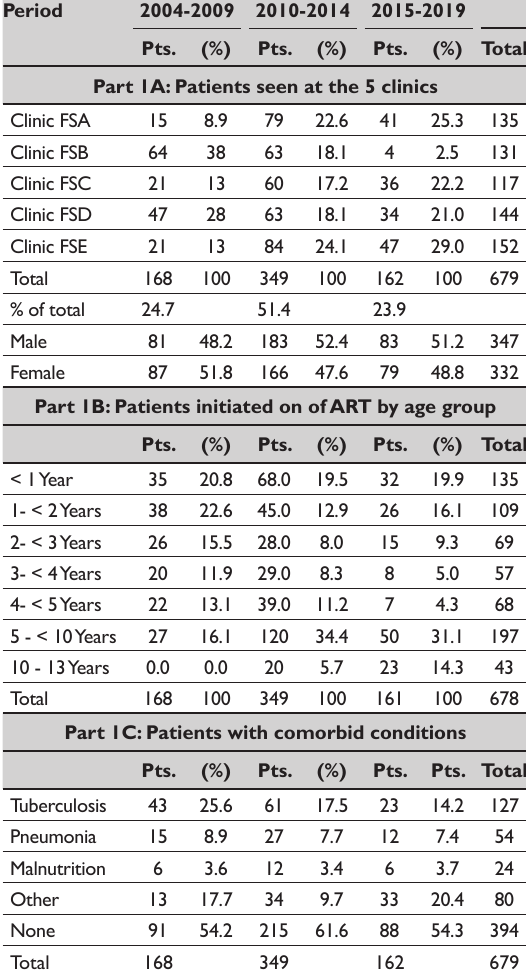
Table 1: The number and proportion (%) of patients (Pts. ) that were initiated on antiretroviral therapy (ART) during each policy period; per clinic (Part 1A), by age group (Part 1B) and with comorbid conditions (Part 1C)